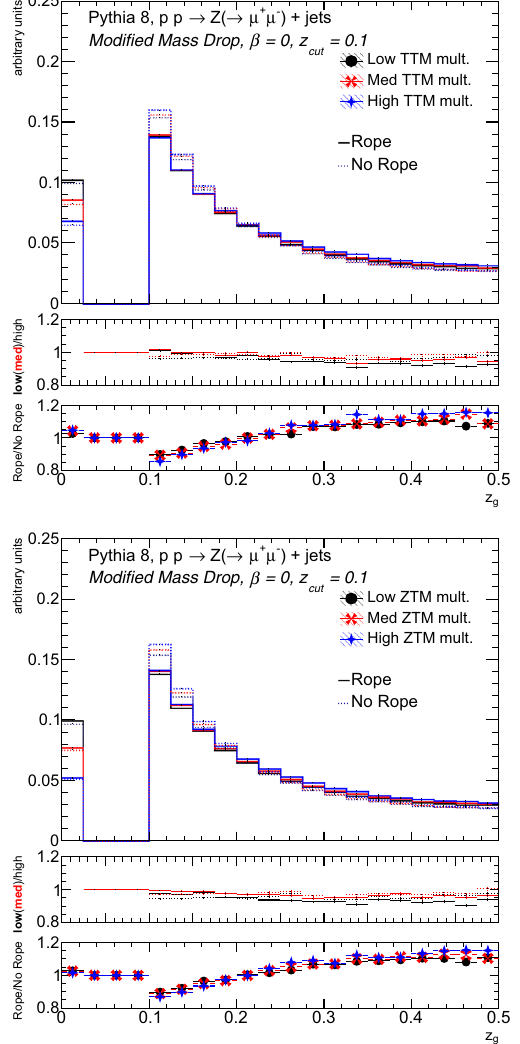
panel, the ratio between the Rope and standard hadronization models is displayed for all three multiplicity regions. Due to the algorithm value z cut = 0 . 1, z g ≥ 0 . 1; when the entire jet is groomed away, z g = 0. The top plots use TTM for the multiplicity while the bottom plots use